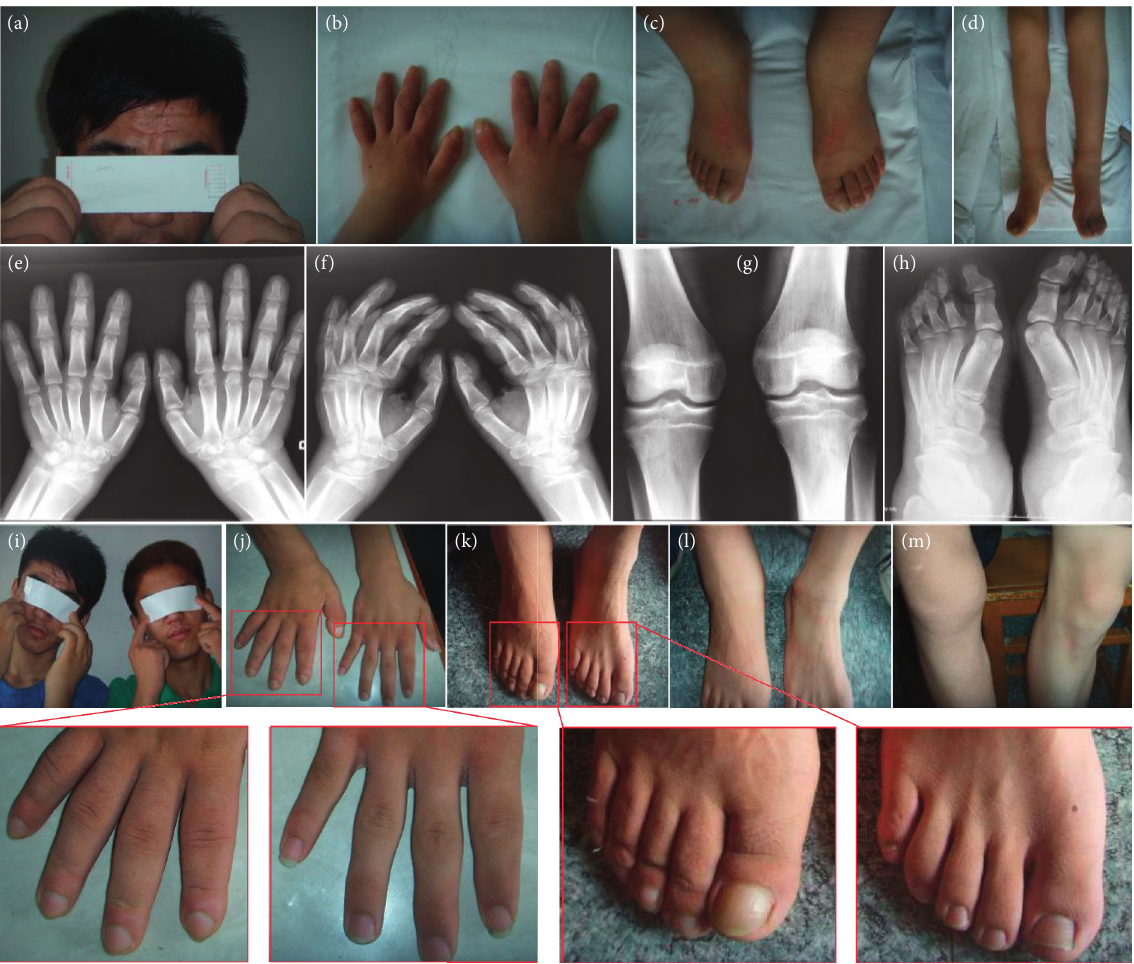
Figure 2: Clinical manifestations of the twin brothers. a–h. Clinical features and radiographs of the proband. i–m. Clinical features of the proband and his twin brother (left, the proband; right, his twin brother). a, i. Thickening and furrowing of the facial skin. b c, j, and k. Digital clubbing of the fingers and toes. d, l, and m. Swelling of the knees and ankles. e–h. Radiographs of the hands, knees, and